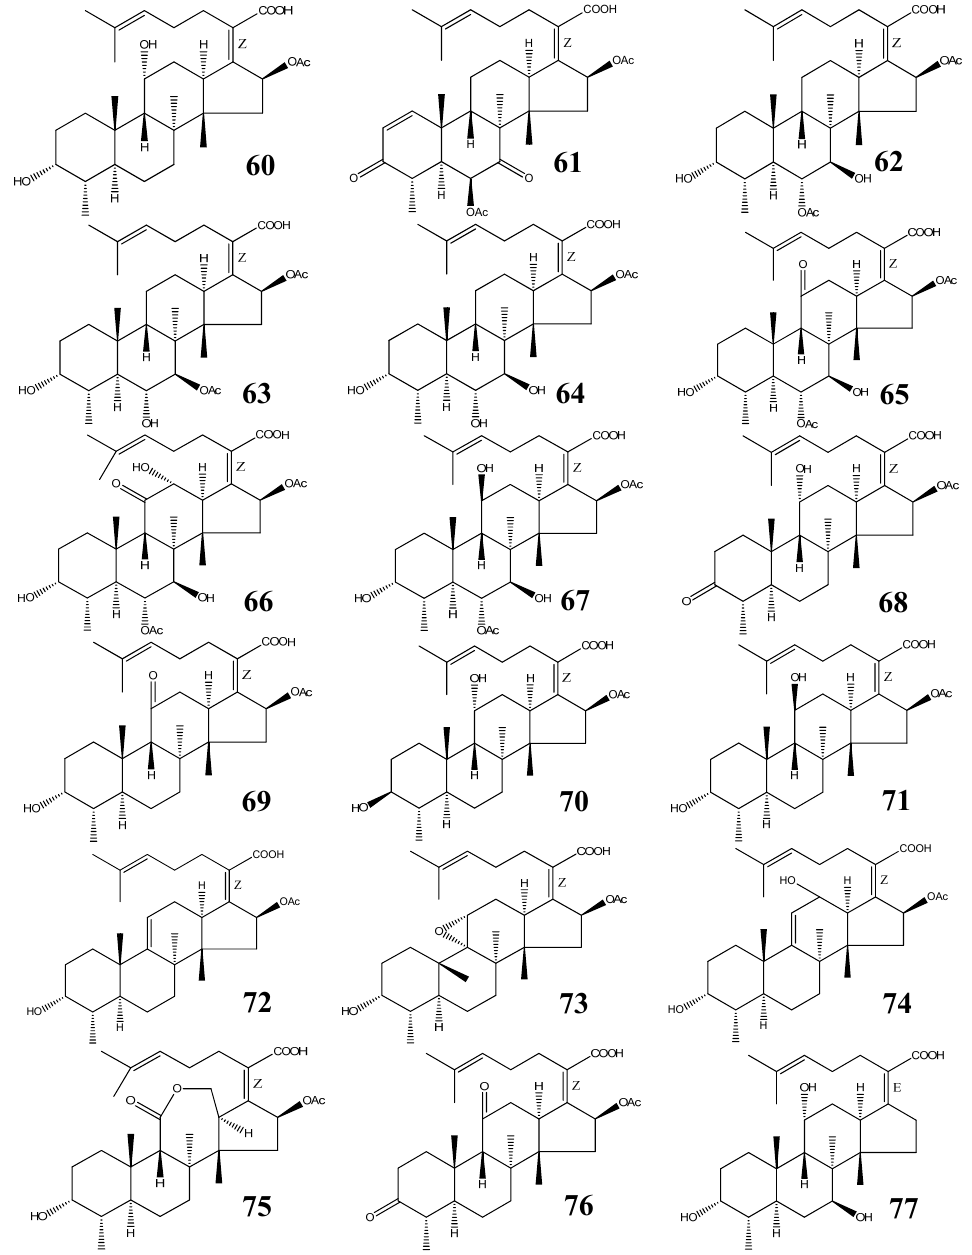
Figure 8. Structures of fusidane triterpenes.